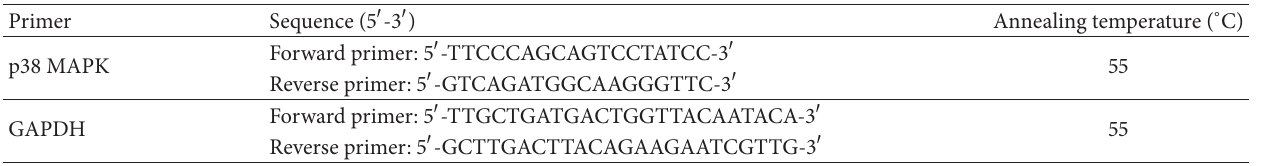
Table 1: Primer sequences.